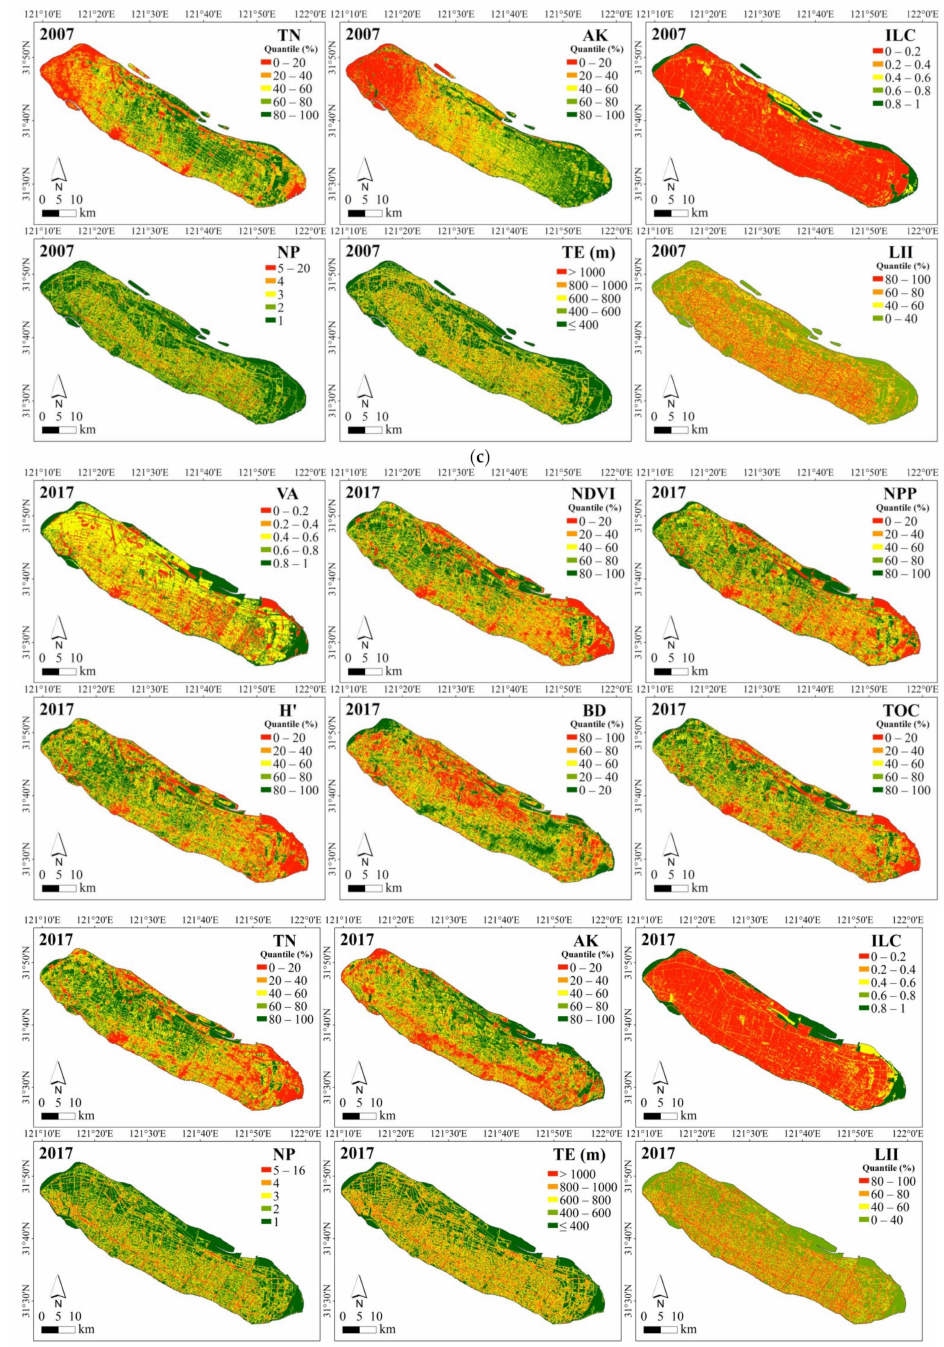
Figure 3. ( a ) Spatial distributions of the 12 factors in 1988. ( b ) Spatial distributions of the 12 factors in 1995. ( c ) Spatial distributions of the 12 factors in 2007. ( d ) Spatial distributions of the 12 factors in 2017. Abbreviations for the factors are the same as for Figure